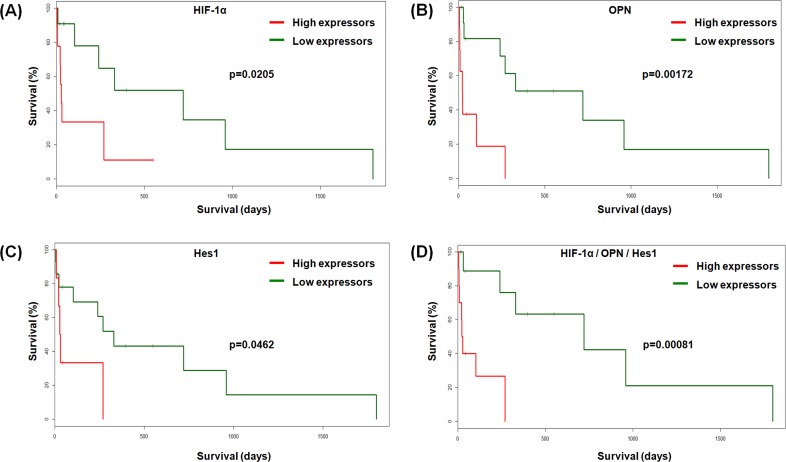
Survival analysis of GBM patients in relation to expression of the components of hypoxia-Notch gene signature.Kaplan-Meier plots showing comparison of survival of GBM patients (n = 21) segregated as high and low expressors of HIF-1α, OPN and Hes1, individually as well as in combination. The p-value indicates the significance of the difference in survival between the two groups of GBM samples. The fold expression thresholds that were used to draw the plots were: HIF-1α = 1.5; OPN = 5.0; Hes1 = 1.5 and HIF-1α/OPN/Hes1 = 8.0.